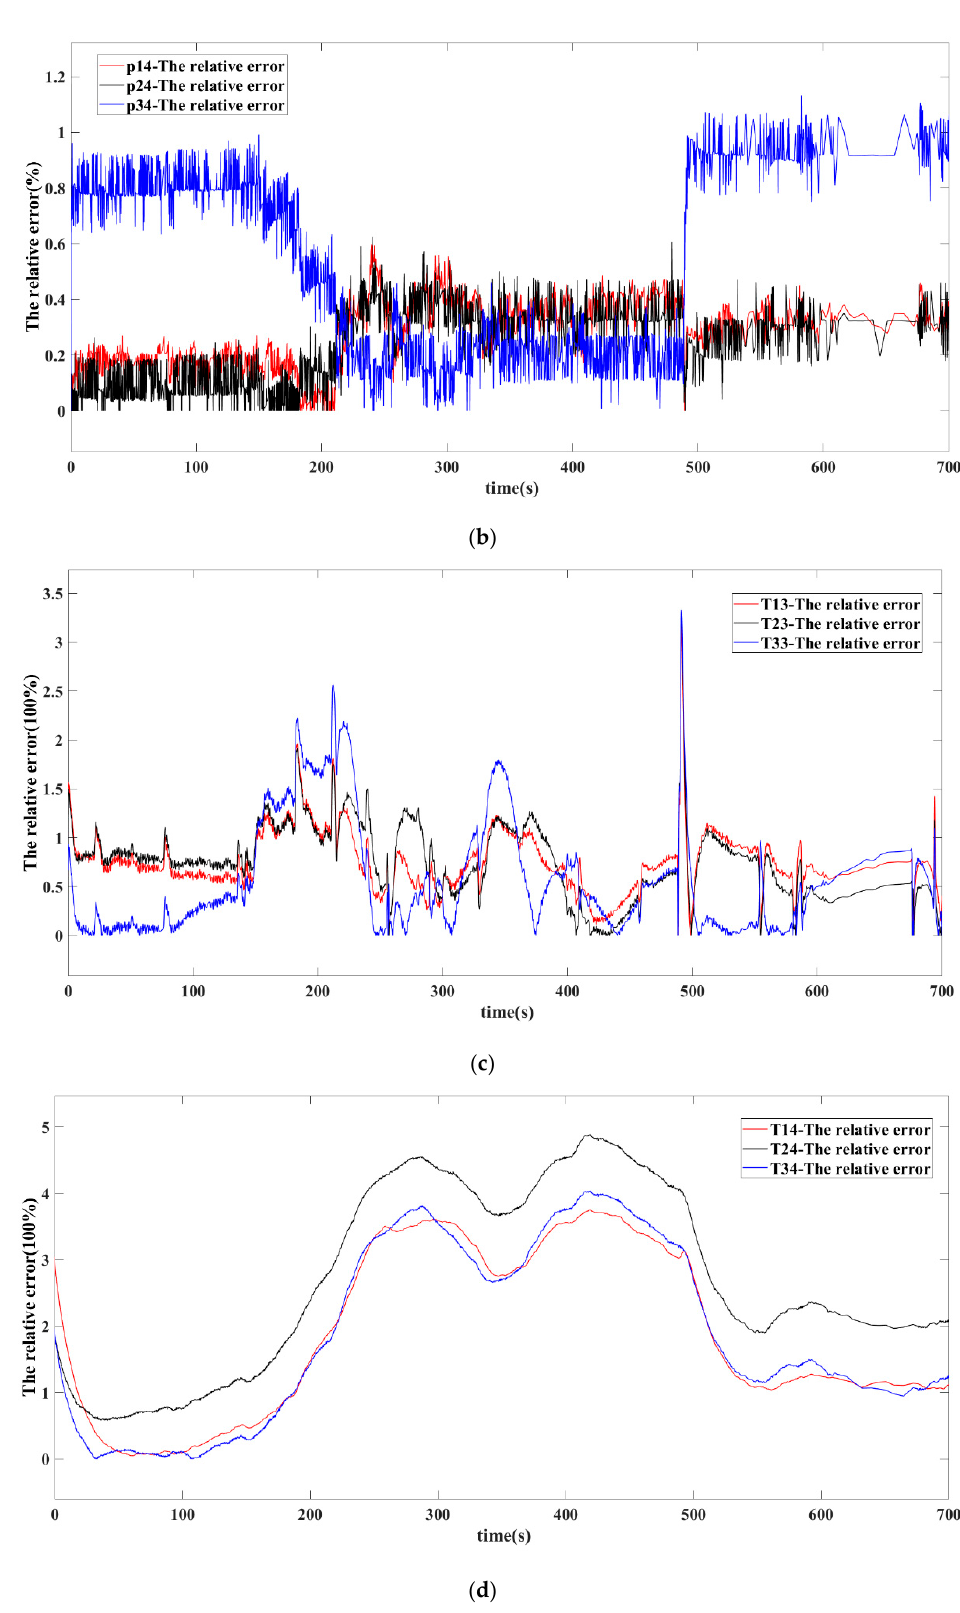
Figure 8. The relative error of simulation and experimental results. ( a ) The relative error of inlet pressure, ( b ) the relative error of outlet pressure, ( c ) the relative error of inlet temperature, ( d ) the relative error of outlet temperature.